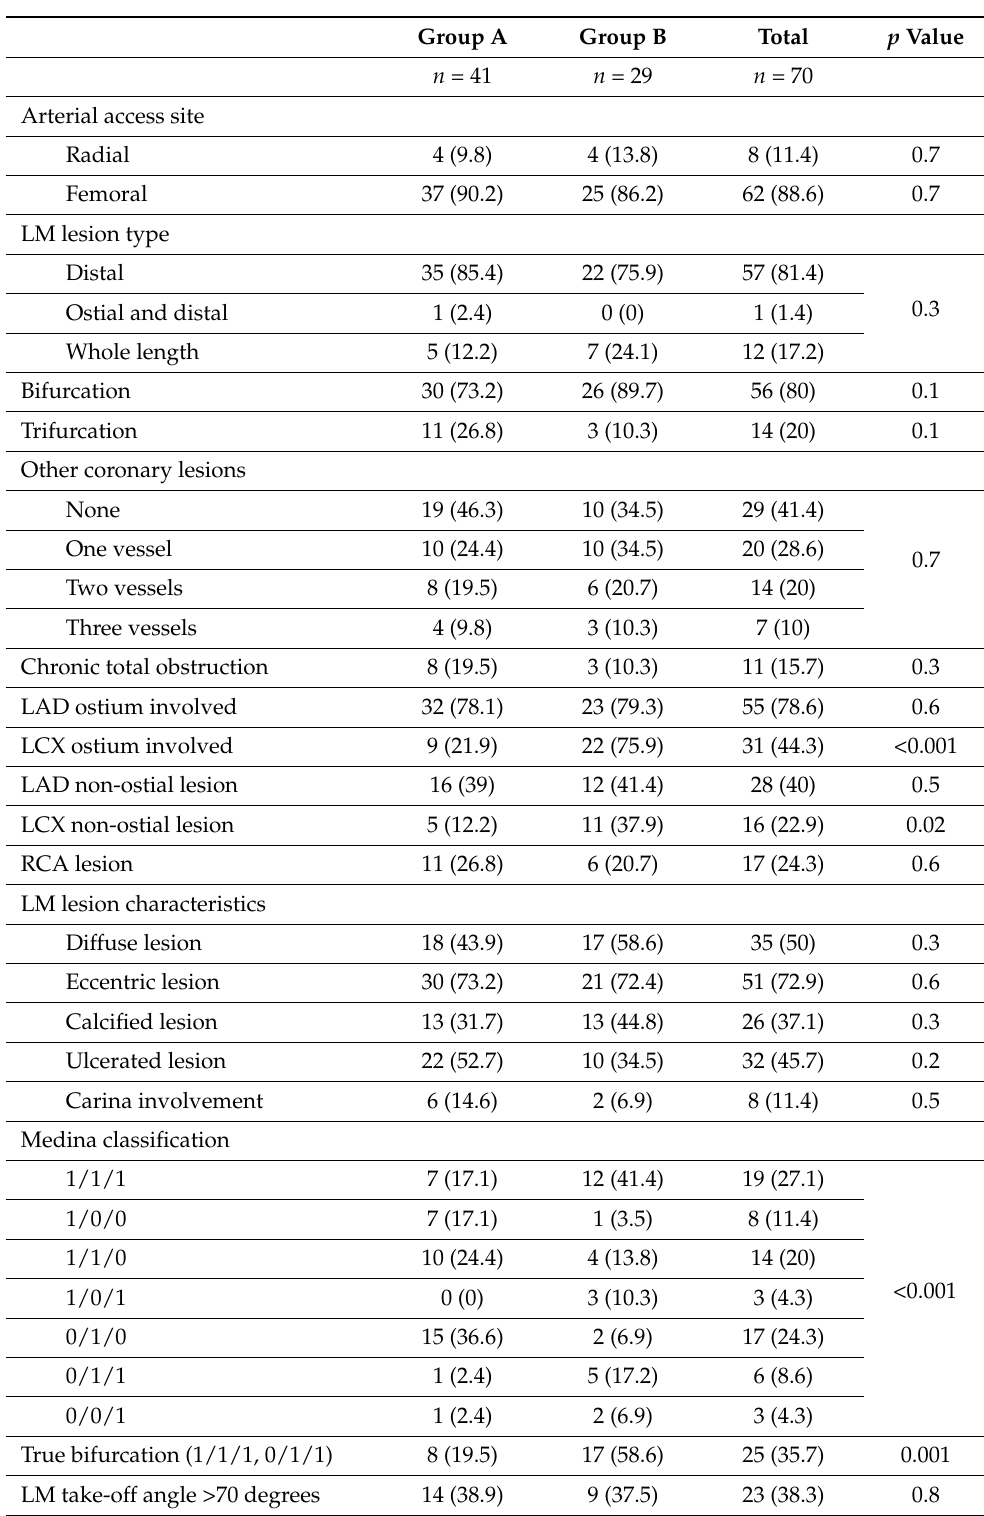
Table 2. Angiographic findings of patients with unprotected left main coronary artery disease and acute coronary syndrome (Group A—one stent strategy; Group B—two stent